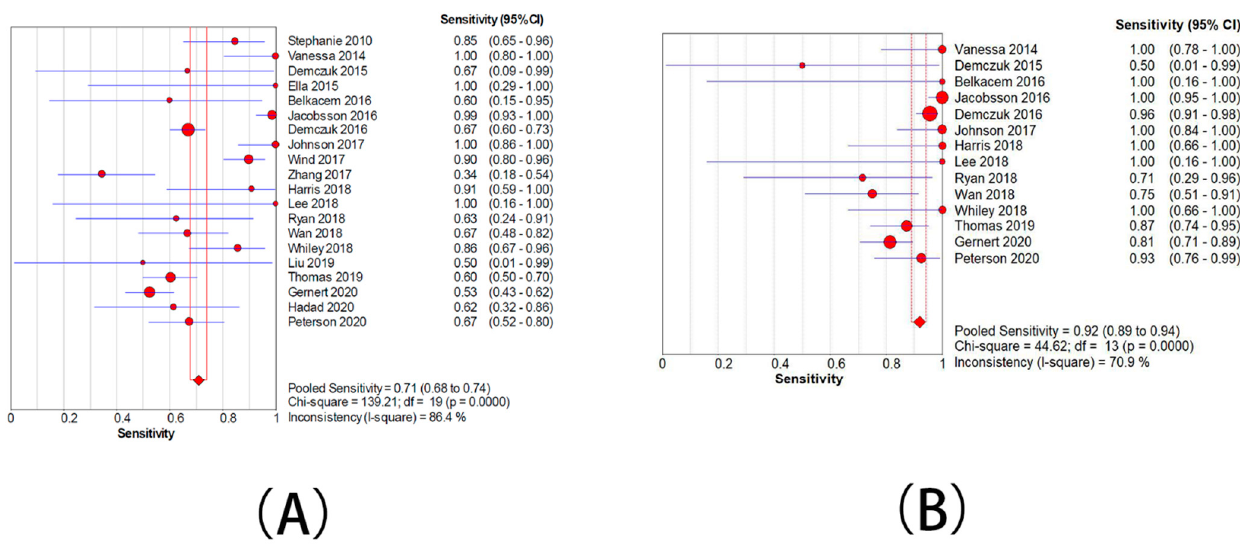
Figure 4. Forest plots for the combined sensitivity from included studies. ( A ) The group with moderate resistance limited to 2–128 mg/L. ( B ) The group with moderate resistance limited to 4–128 mg/L.